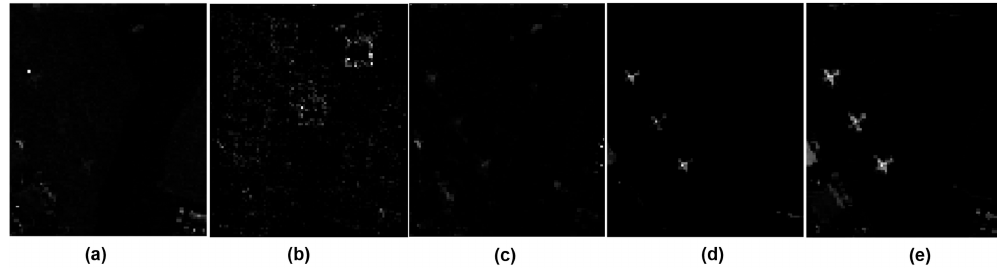
Figure 10. The normalized detection maps of San Diego dataset before threshold segmentation: ( a ) GRX; ( b ) LRX; ( c ) CRD; ( d ) LRaSMD; and ( e ) RSLAD.